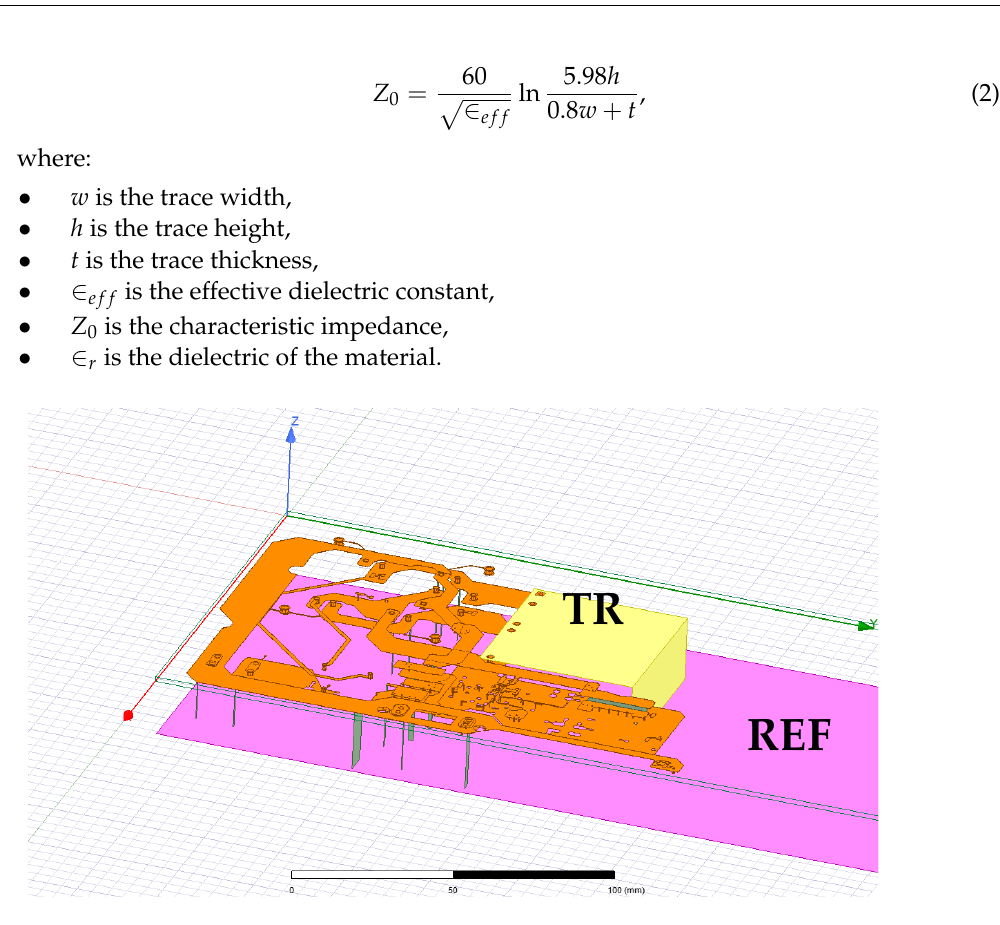
Figure 17. Overview of the HFSS model mesh. 2.3.3. Submodels As the result of both HFSS and Q3D extraction processes, the S-parameter [11] submodels were created. This approach treats the network as a two-port circuit. Only the port variables are considered, which are input and output voltage currents. During HF circuit characterization, those parameters relate to incident, reflected, and transmit- ted voltage waves after the insertion of a two-port network into a transmission line. In- cident waves can be injected into any of the two ports, and they give rise to reflected and transmitted waves. S-parameters are calculated on the basis of incident and reflected waves; they define waves reflected from a particular port in which an incident wave is applied. Those submodels ’ bases were used as an input into the TWIN Builder tool, which includes S-parameters calculated on the base of Q3D and HFSS simulations. For the Q3D simulation, sinks and sources in the simulation are converted to the Twin Builder component based on extracted S-parameters. In the case of HFSS, the ports for the S-parameters were calculated and translated into the appropriate dynamic compo- nents in Twin Builder.